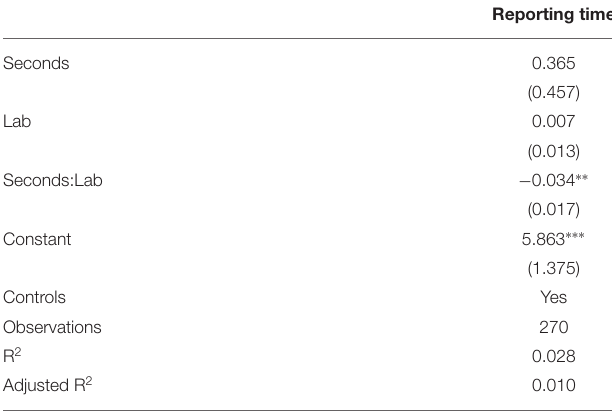
TABLE 3 | Results of OLS